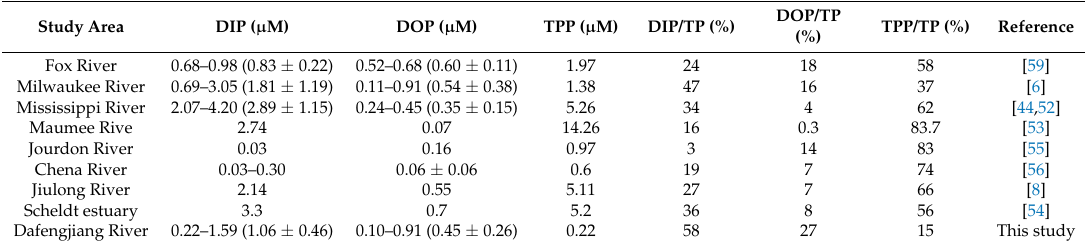
Table 4. Comparisons of the abundance of DIP, DOP, and TPP and their partitioning in TP pool between different rivers. All values are for surface waters. Values in parentheses denote the averaged concentrations and their standard